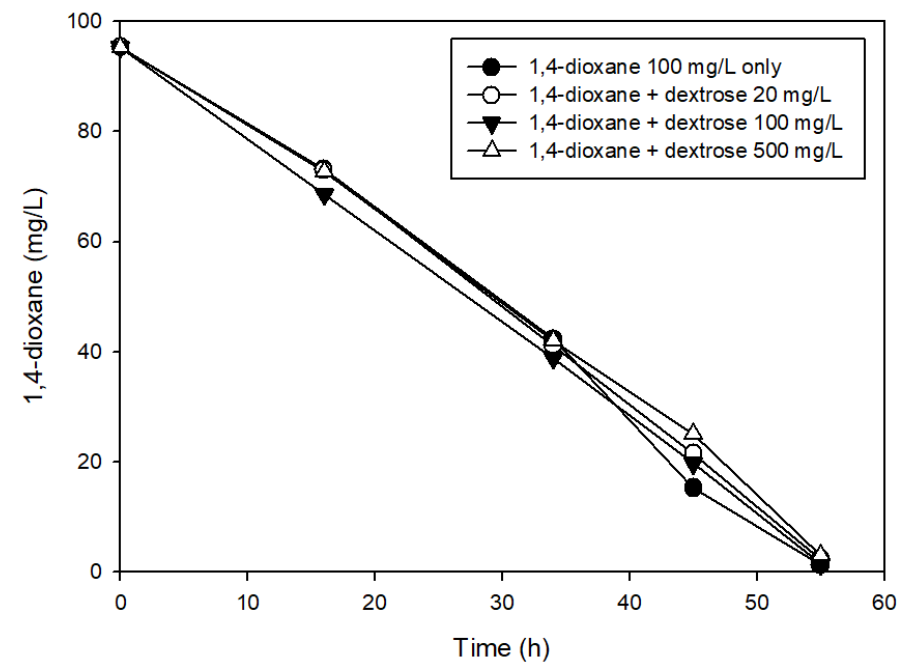
Figure 4. E ff ects of dextrose on the biodegradation of Figure 4. Effects of dextrose on the biodegradation of 1,4-dioxane.